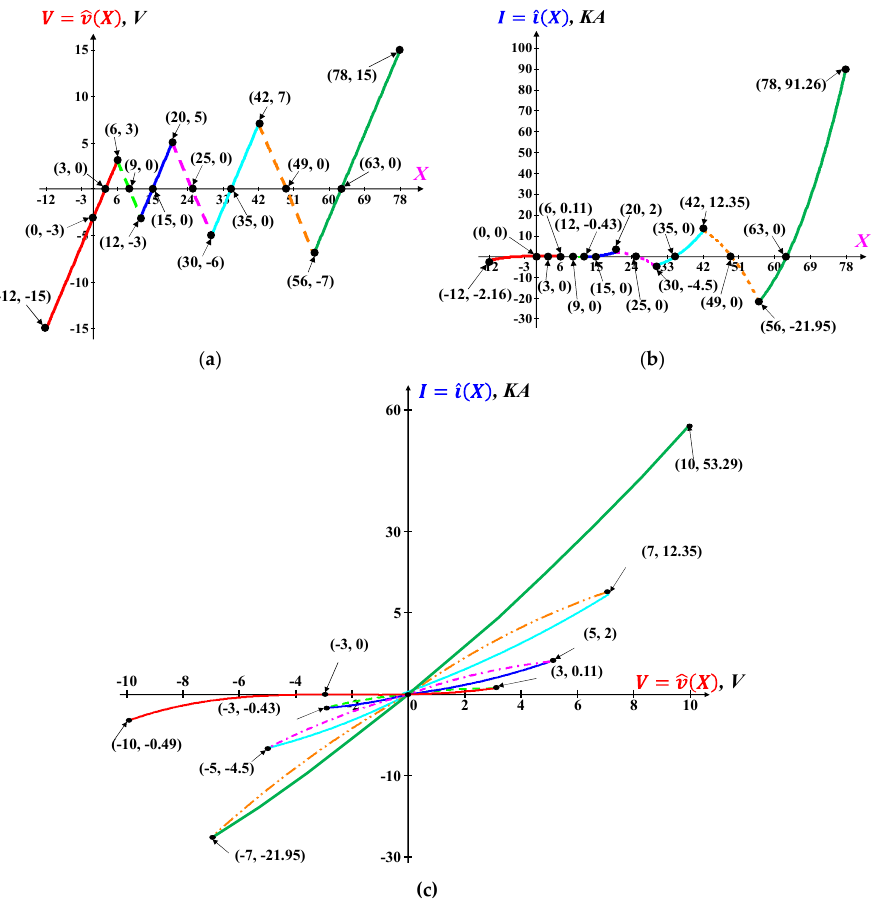
Figure 3. Parametric representation of the 6-lobe CCM . ( a ) Voltage V = ˆ v ( X ) vs. state variable X, and ( b ) current I = ˆ i ( x ) vs. state variable X. ( c ) DC V-I plot, where the coordinates ( V, I ) of each point are extracted from (a) and